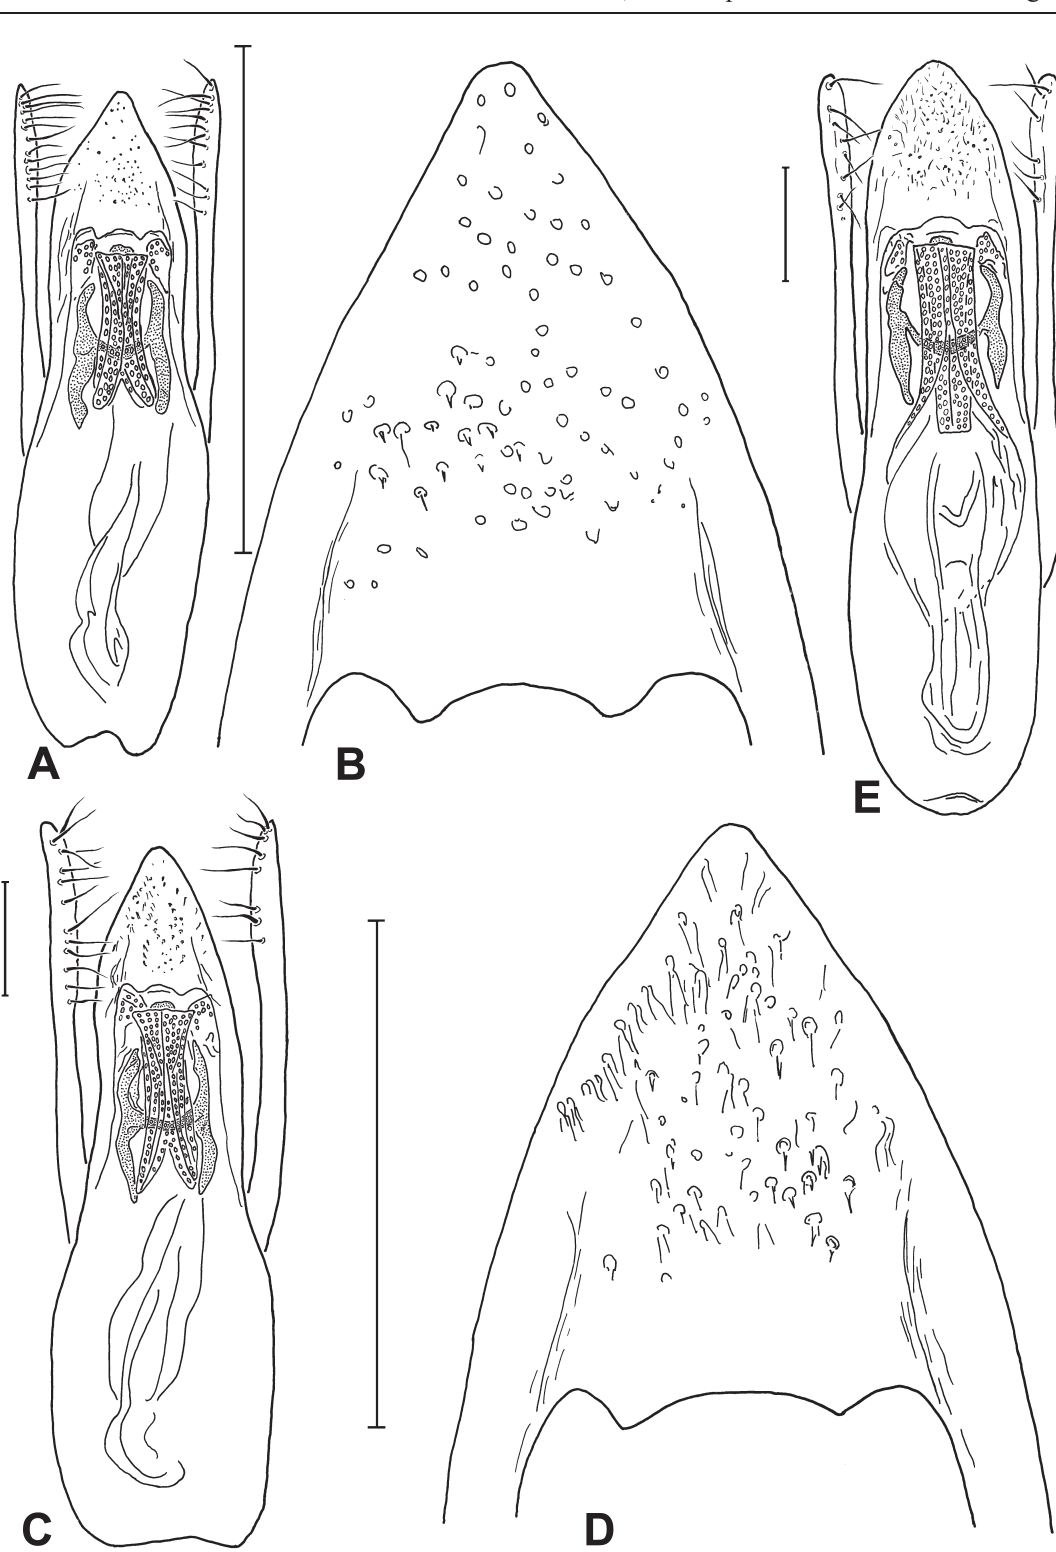
Fig. 1. – A–D : Stenus ( Nestus ) nitens Stephens, 1833: ♂ genitalia, ventral view. A–B : (Russia: Moscow Area: Gorenki). C–D : (Russia: Evenkia: Stolbovaya River). A, C . Aedeagus. B, D . Apical part of median lobe. – E . S. ( N. ) labilis Erichson, 1840: ♂ (Russia: S yamal: nr. Salekhard). Aedeagus, ventral view. – Scales = 0.1